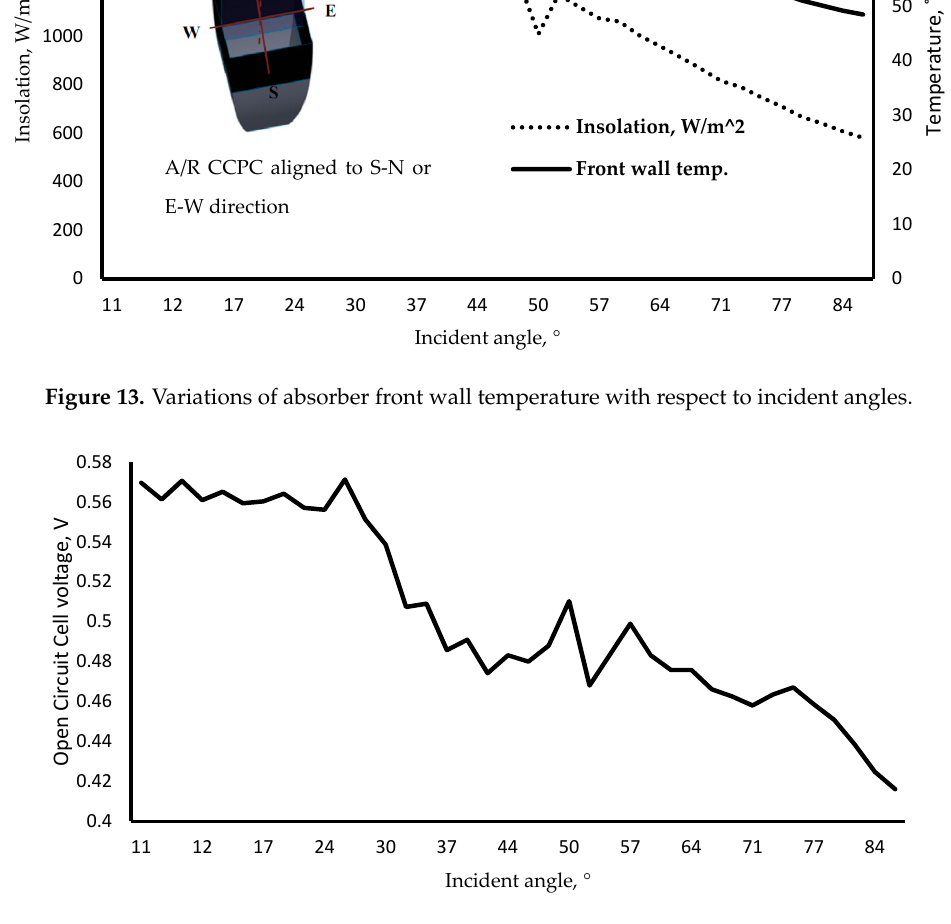
Figure 14. Variation of cell voltage with various angles of incidence. Please note that the peak performance was a till incident angle of 30°, beyond the voltage drops drastically.